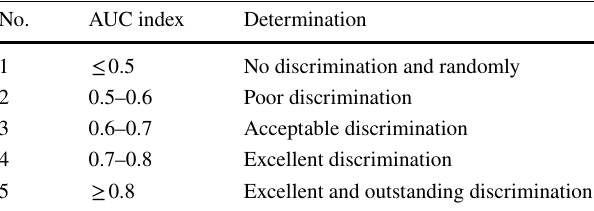
Table 4 Determination of discriminations for AUC values (after Khatami et al.